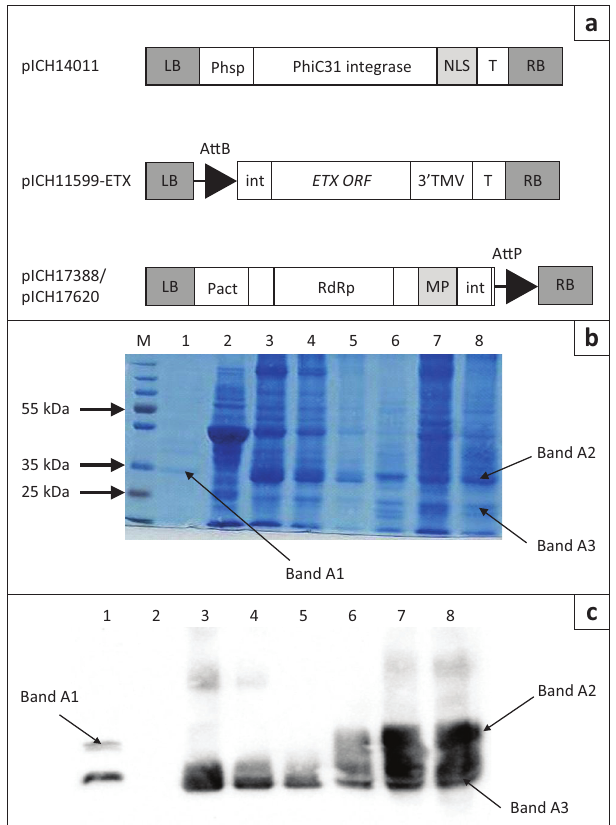
FIGURE 1: Expression of epsilon toxin open reading frame in Nicotiana benthamiana . (a) schematic representation of the plasmid constructs, (b) sodium dodecyl sulphate–polyacrylamide gel analysis of the agroinfiltrated recombinant recombinant toxoid and (c) western blot analysis of recombinant toxoid